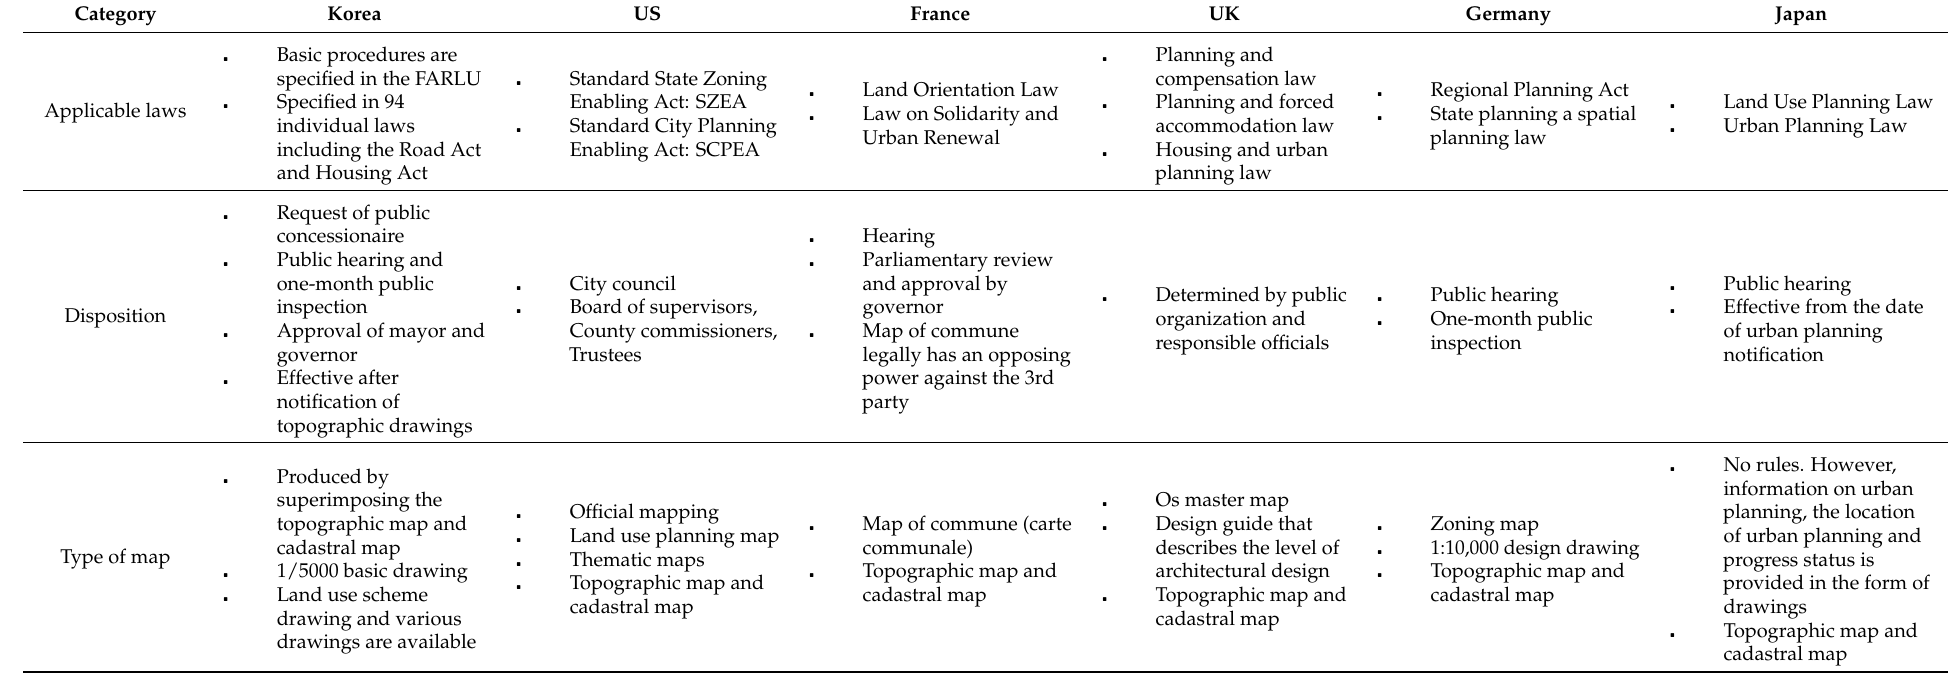
Table 1. Comparison of laws, dispositions, and map categories for zoning. Source: National Assembly of Korea (recompiled) [33–37]. Category Korea US France UK Germany